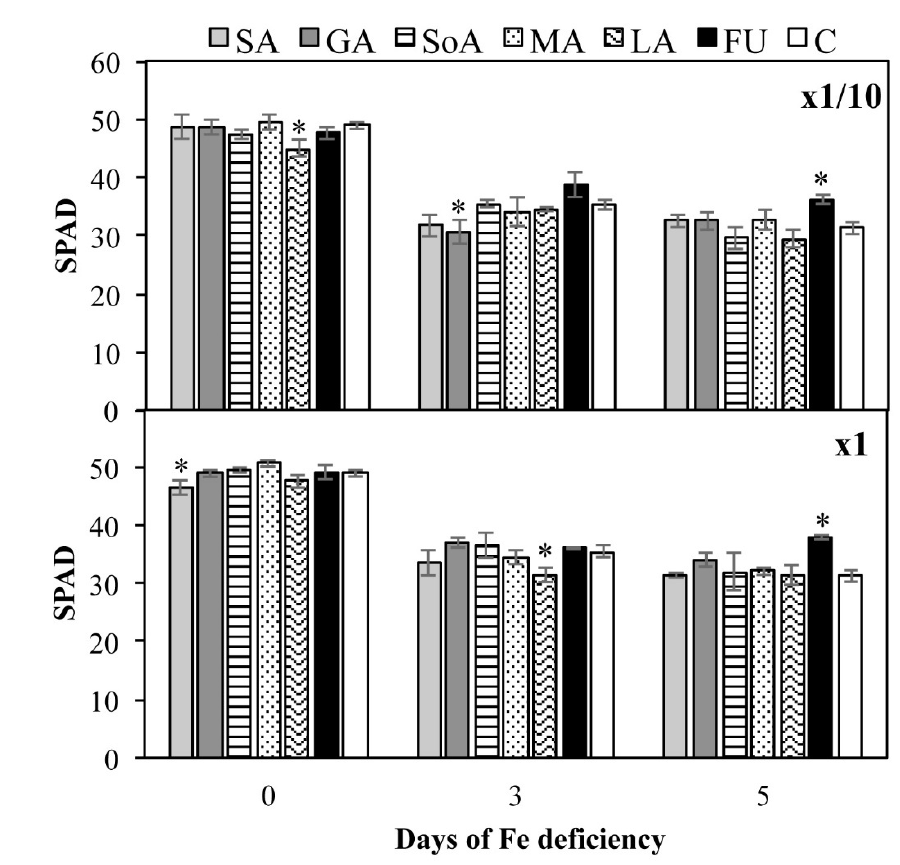
Figure 4. SPAD (chlorophyll index) in new leaves of tomato plants treated with organic com- pounds (salicylic acid (SA), gallic acid (GA), sodium alginate (SoA), mannitol (MA), laminarin (LA), and fucose (FU)) at two concentrations (×1/10 and ×1) at day 0, 3, and 5 of Fe deficiency. A control (C) treatment without organic compound application was performed. Data are means ± SE ( n = 3). Significant differences between treatments ( p < 0.10) with respect to the control are indicated by asterisk (*).